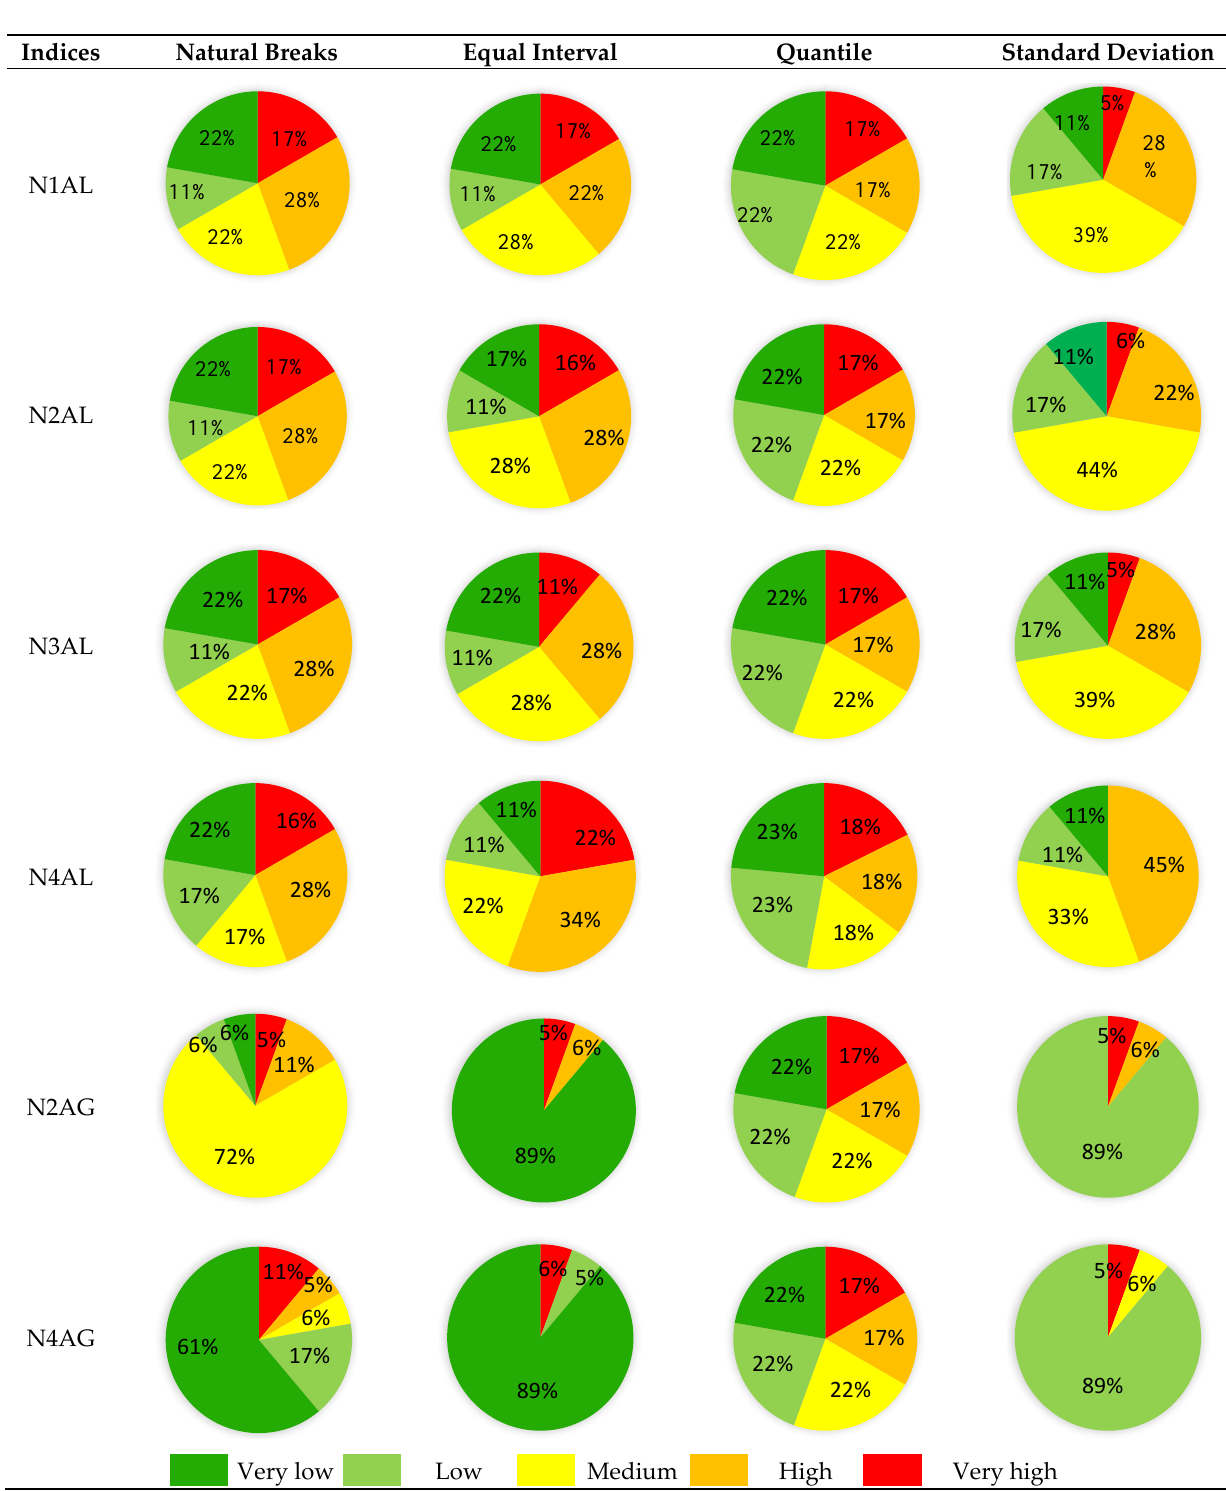
Figure 8. Percentage of the census block (n = 18) for each vulnerability class according to the different normalization and aggregation methods. N1 = Min-max normalization, N2 = Z-scores normalization, N3 = distance to target normalization, N4 = ranking normalization, AL = linear aggregation, and AG = geometric aggregation.